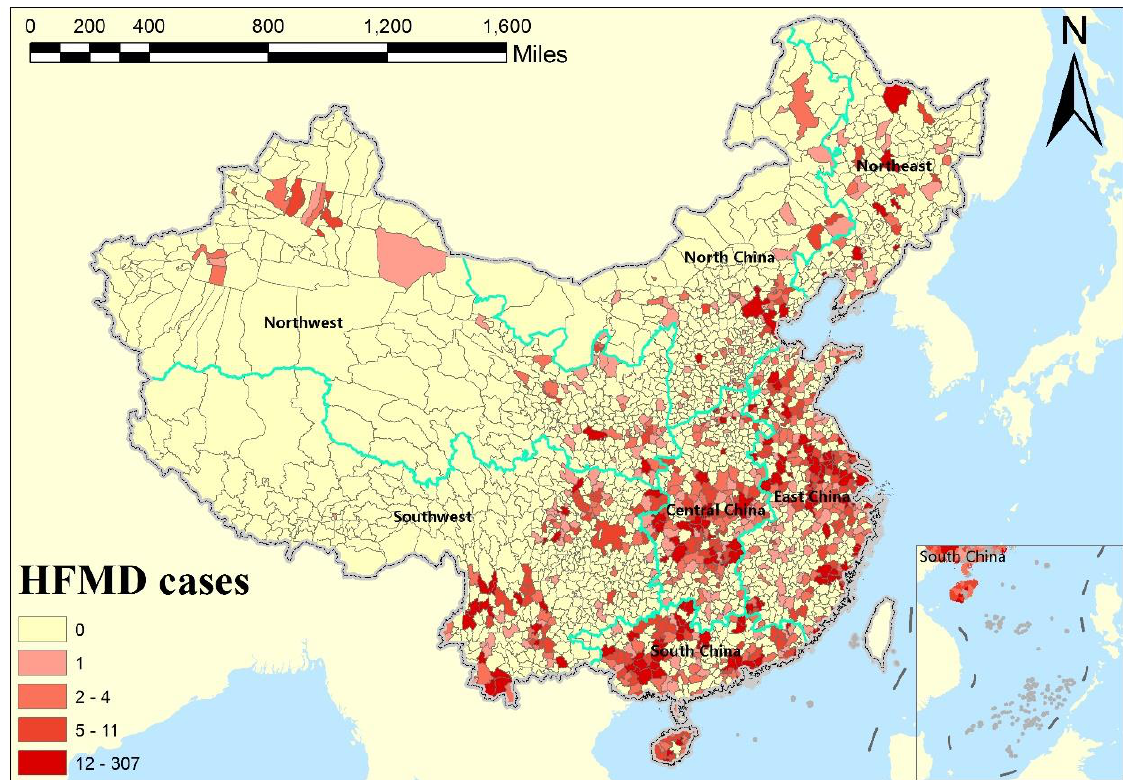
Figure 1. Geographical distribution of reported hand, foot, and mouth disease (HFMD) cases in Mainland China in January 2009.